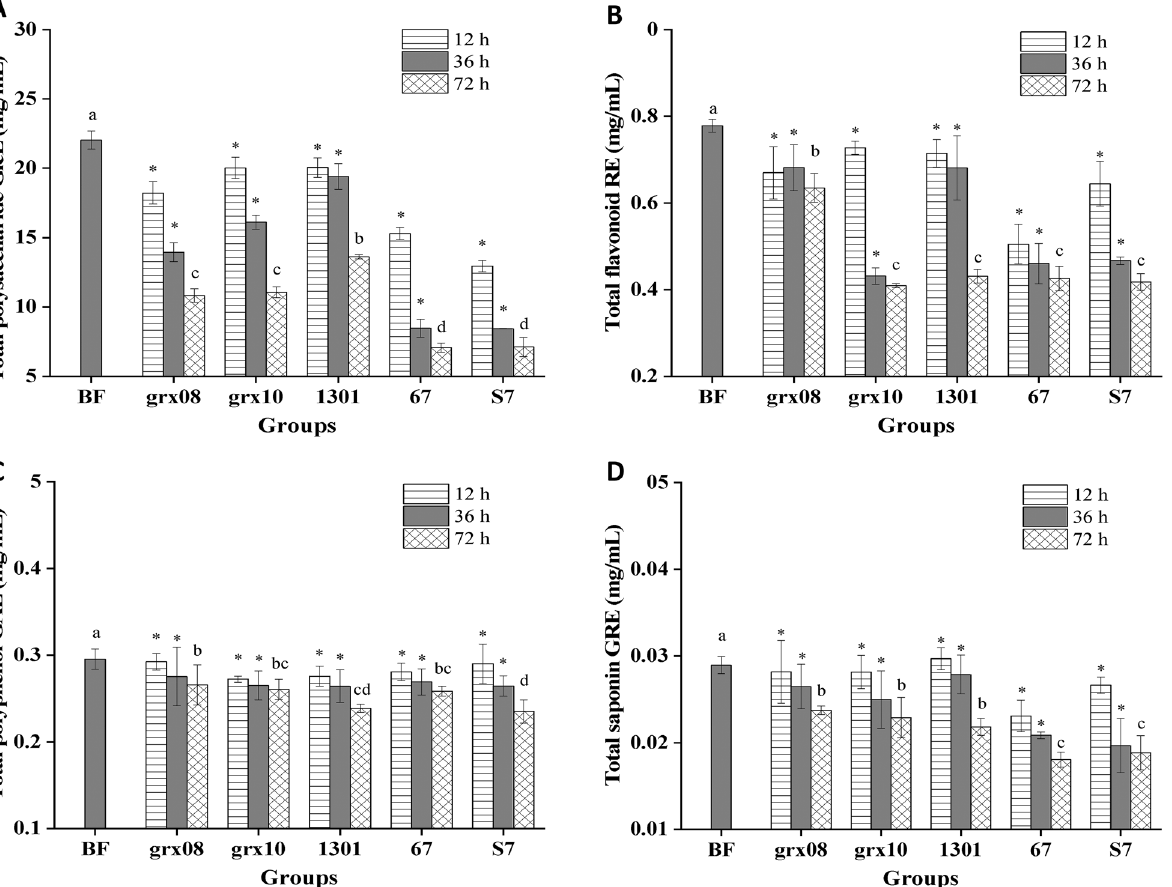
Fig. 2 Changes in the contents of functional components in FH06 fermented by LAB. A Total polysaccharide; B Total flavonoid; C Total polyphenol; D Total saponin. * Indicates a significant difference from before fermentation (BF) ( P < 0.05). Different letters indicate significant differences before fermentation (BF) and after fermentation for 72 h (P < 0.05). glucose equivalent (GlcE), rutin equivalent (RE), gallic acid equivalent (GAE), ginsenoside Re equivalent